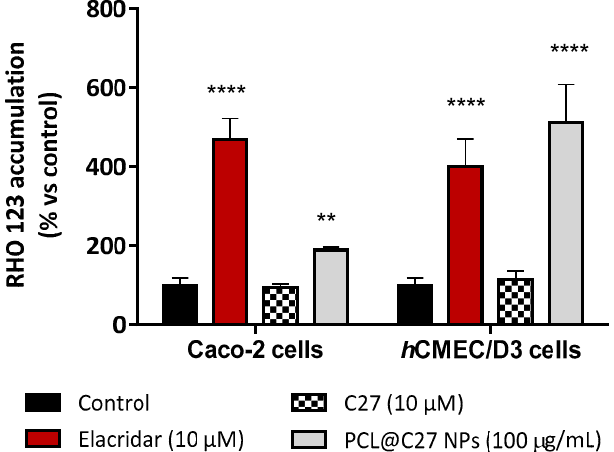
Figure 9. Accumulation of Rhodamine (RHO) 123 in Caco-2 and hCMEC / D3 cells. Data are expressed as percentage of fluorescence dye accumulation in control cells exposed only to RHO 123, arbitrarily set as 100%, and are the means ± SD of three independent assays. In all cases, p -values lower than 0.05 were considered significant (** p < 0.01 and **** p < 0.0001).